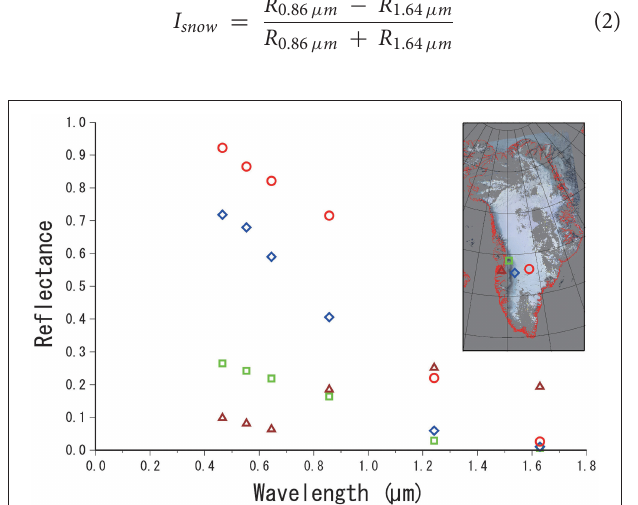
FIGURE 1 | Spectral reflectance of snow (68 ◦ 56 ′ 33 ′′ N, 42 ◦ 27 ′ 16 ′′ W, red circle), bare ice (68 ◦ 05 ′ 10 ′′ N, 48 ◦ 01 ′ 23 ′′ W, blue diamond), dark ice (69 ◦ 32 ′ 25 ′′ N, 50 ◦ 26 ′ 56 ′′ W, green square), and bare soil (68 ◦ 23 ′ 02 ′′ N, 53 ◦ 48 ′ 13 ′′ W, brown triangle) and RGB color composite image band 1, 4, and 3 taken on 12 July 2012 derived from MODIS.